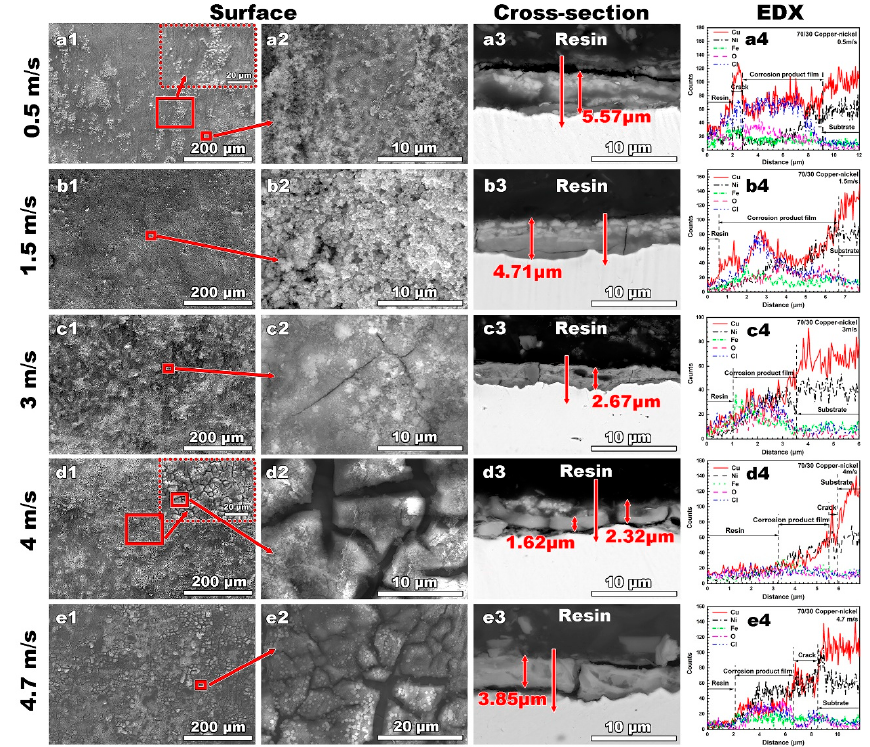
Figure 7. Surface and cross-section morphologies of the 70/30 copper–nickel sample after the 10-day erosion–corrosion test in 1% NaCl solution at different flow velocities: ( a1 – a3 ) 0.5 m/s; ( b1 – b3 ) 1.5 m/s; ( c1 – c3 ) 3 m/s; ( d1 – d3 ) 4 m/s; ( e1 – e3 ) 4.7 m/s; ( a4 – e4 ) the corresponding EDS profiles along the red lines marked in ( a3 – e3 ), respectively.